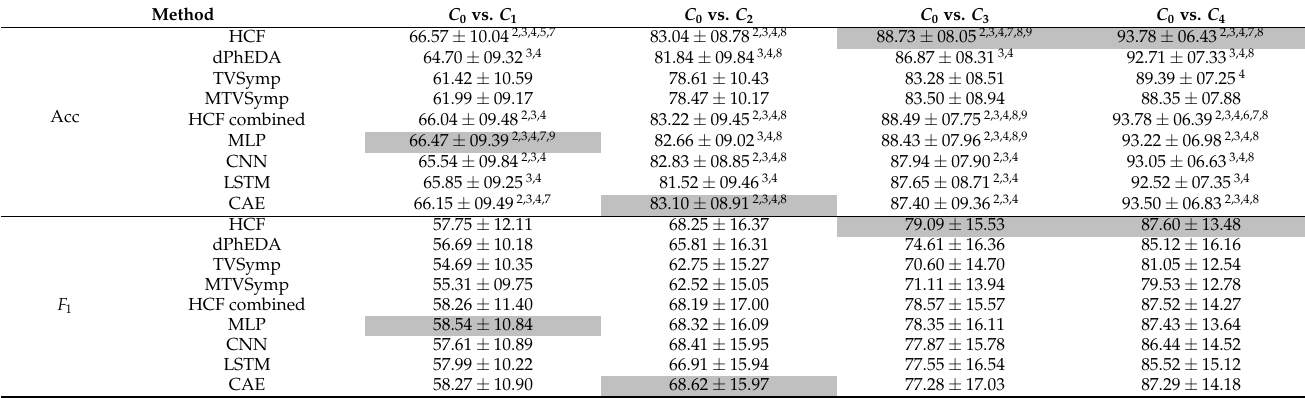
Table 10. 5 × LOSO average performance using the EDA (RespiBan) sensor of the PMDB for several feature extraction methods in combination with a Random Forest. In contrast to previous tables, the CoVAS parameters are used as label here. Performance metrics are given as average accuracy (upper) and F 1 score (lower half) ± standard deviation. The best performing approach is highlighted in grey. Moreover, a paired student’s t -test with a significance level of 5% was performed to check the significance in differences between the accuracies obtained by each pair of approaches for each classification problem. 1,2,3,4,5,6,7,8,9 indicate a significant improvement compared to the HCF, dPhEDA, TVSymp, MTVSymp, “HCF combined”, MLP, CNN, LSTM, and CAE approaches,